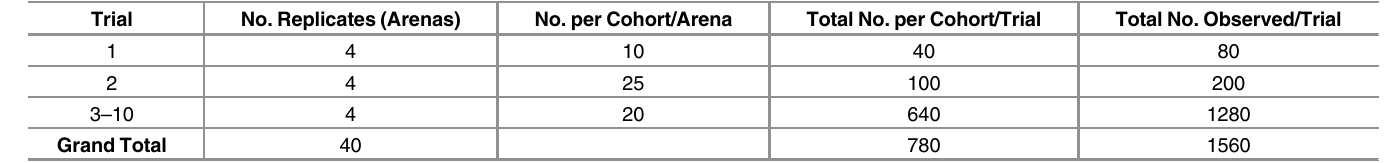
Table 1. Sample size of Aedes aegypti 1 (exposed and unexposed) 2 observed during study. Trial No. Replicates (Arenas) No. per Cohort/Arena Total No. per